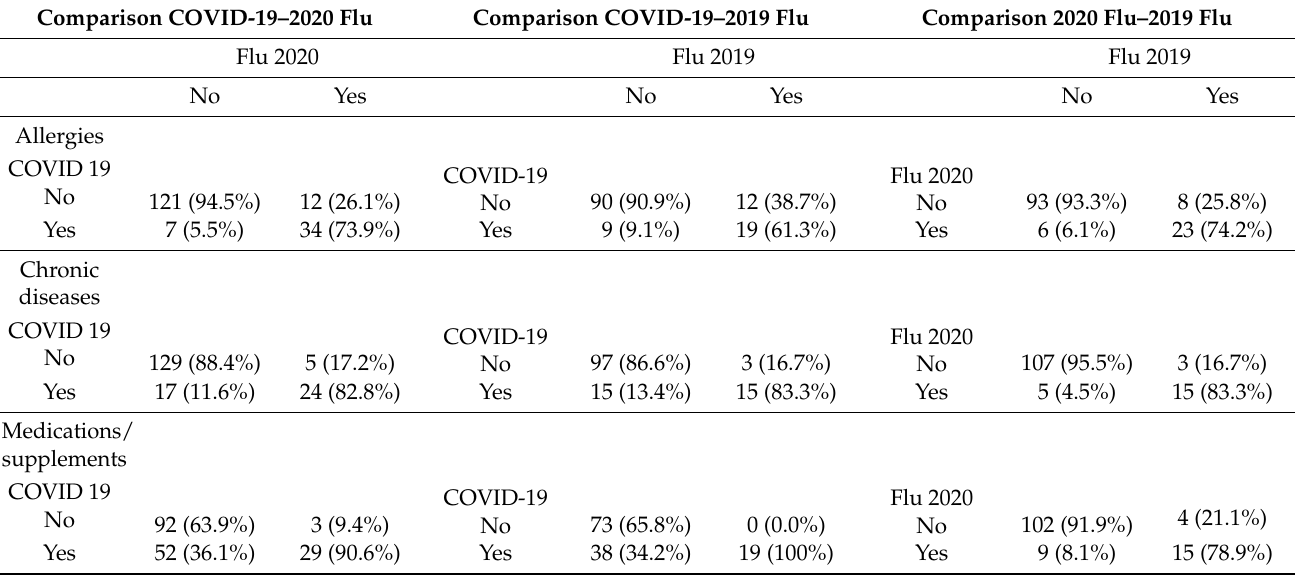
Table 3. Number of outcomes reported in each pairwise combination of